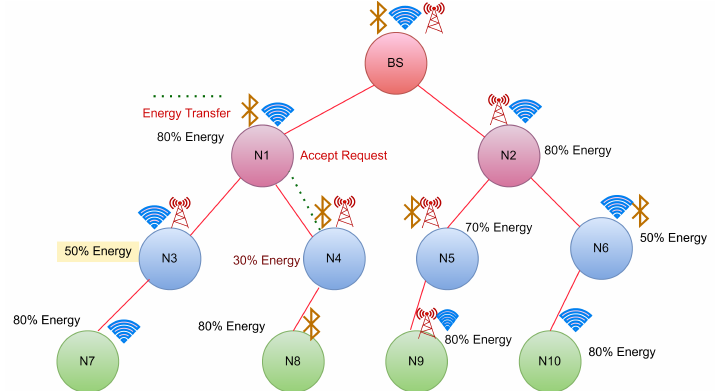
Figure 8. Case 3:Energy transfer from N1 to